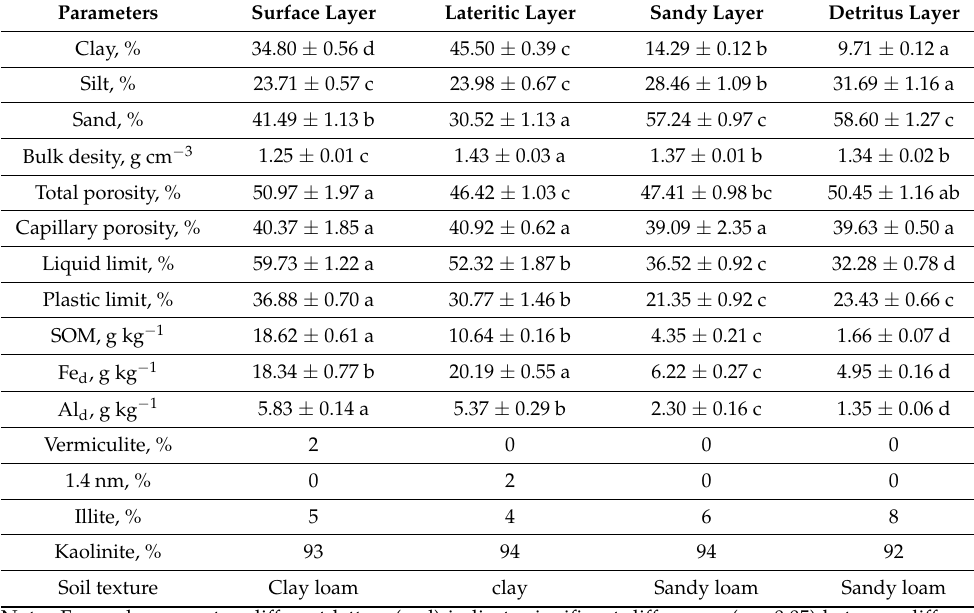
Table 2. Physicochemical properties of experimental soils.